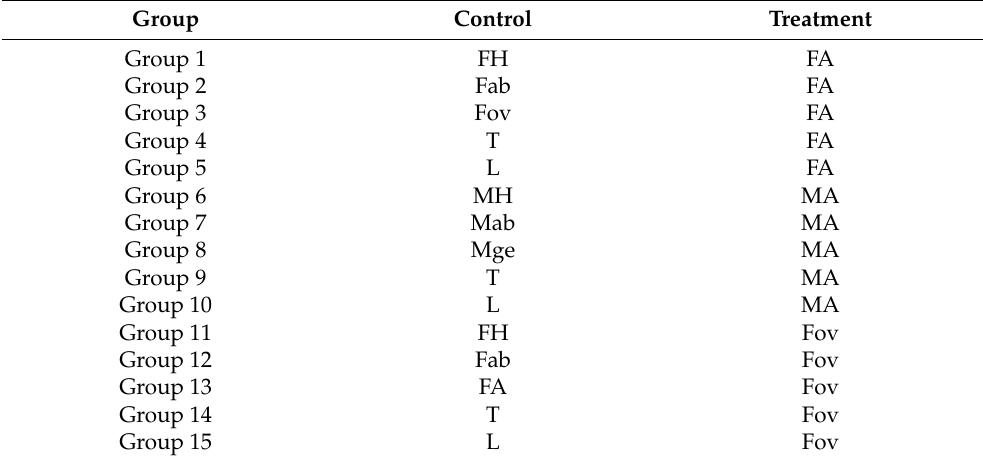
Table 1. The comparison groups of differential expression gene analysis. Group Control